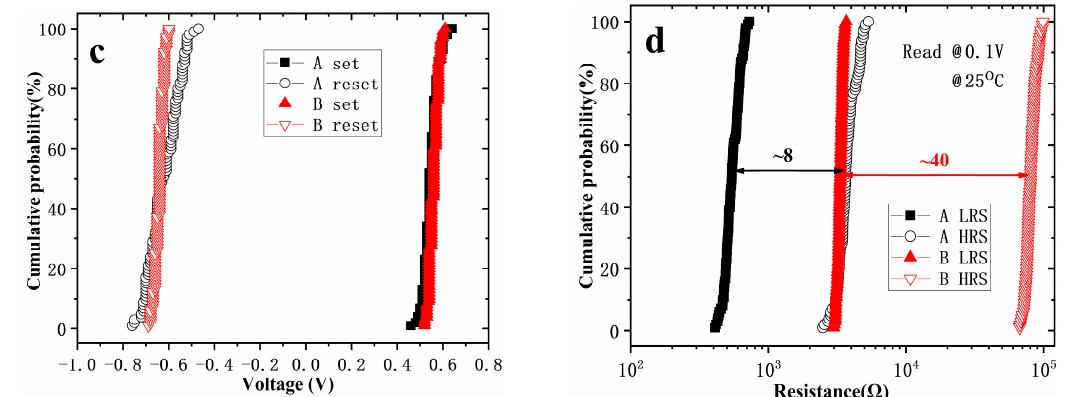
Figure 3. I-V characteristics of the first 100 DC scans of 2 × 2 μ m 2 and 10 nm thick HfO x devices without annealing ( a ) and annealed at 500 °C ( b ), and their accumulative probability of set/reset voltages ( c ) and HRS/LRS ( d ).